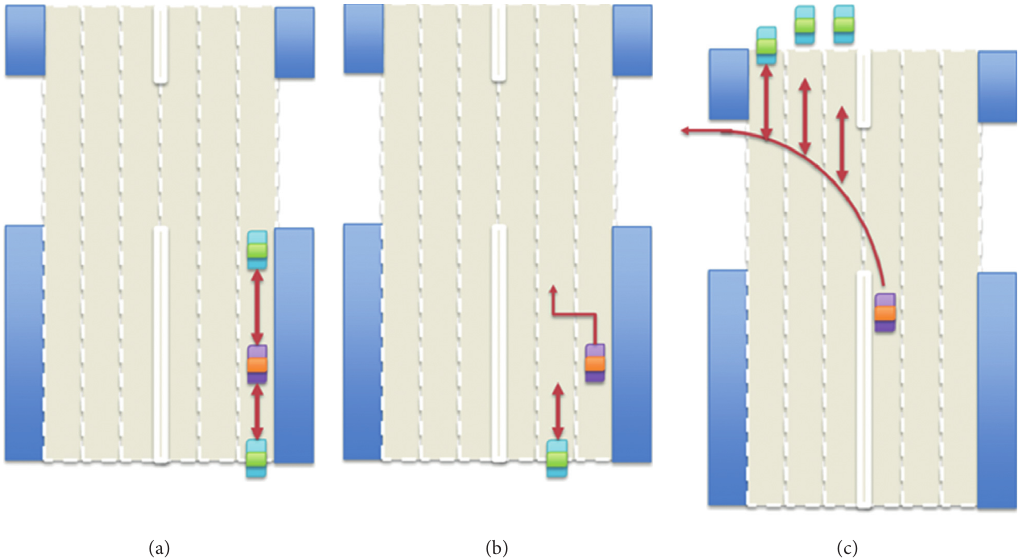
Figure 2: Gap acceptance for car-following (a), lane-changing (b), and left-turning (c) in the Cautious driving